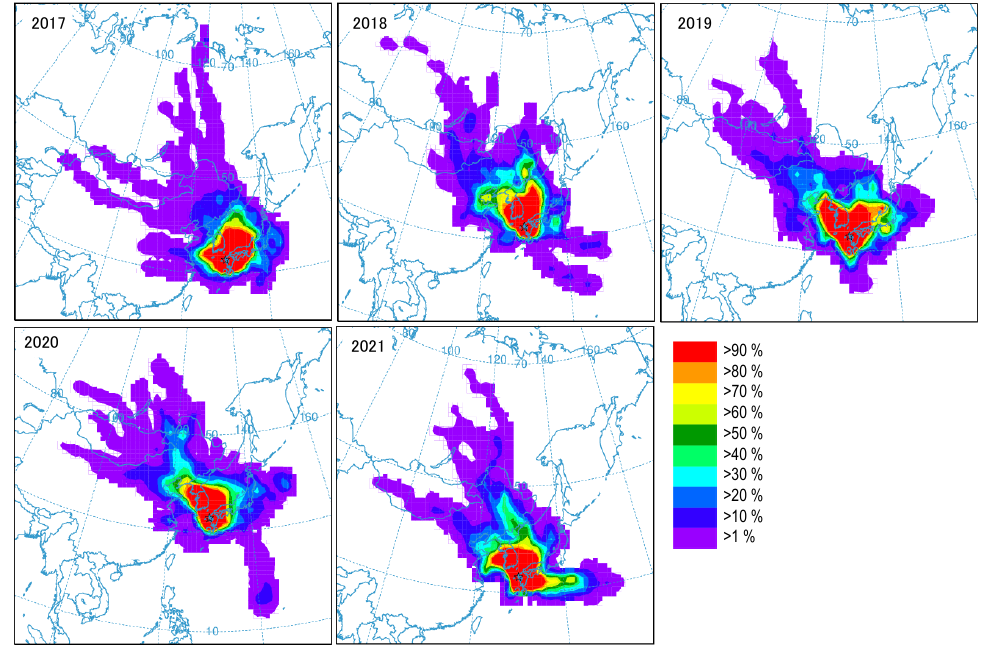
Figure 5. Frequency of residence of back trajectories in a grid cell in autumn calculated by HYSPLIT Model of the National Oceanic and Atmospheric Administration, USA. The analysis period was set from 29 September to 3 November in each year.